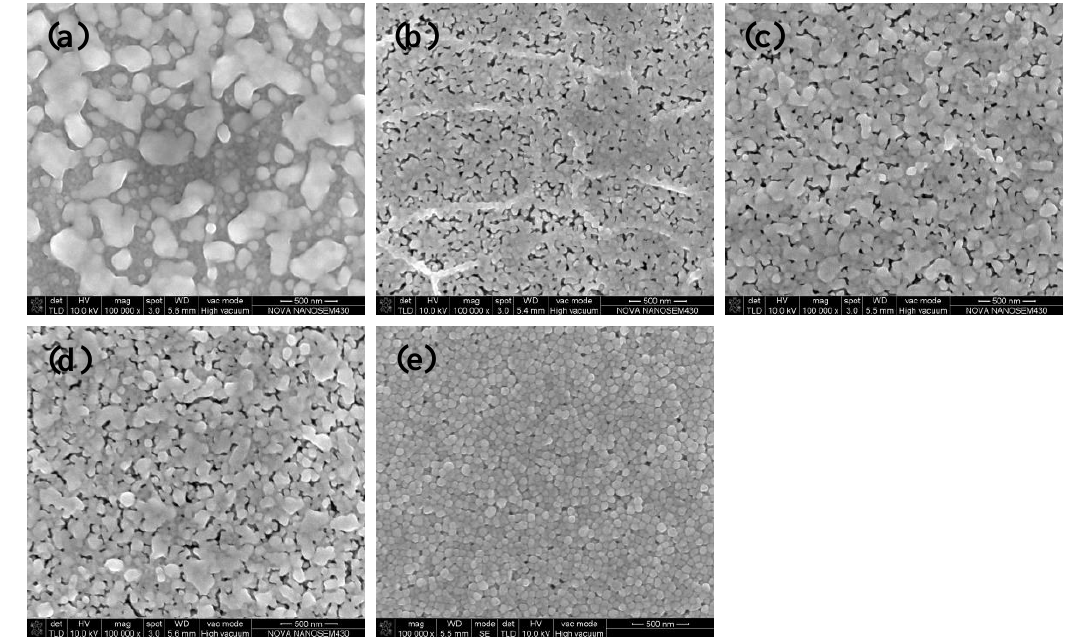
Figure 4. SEM images of silver films with UV curing at: ( a ) D = 37 cm for 270 s; ( b ) D = 23 cm for 270 s; ( c ) D = 23 cm for 480 s; ( d ) D = 25 cm for 480 s; ( e ) D = 25 cm for 480 s [20]. ( a – d ) were the films based on MOD ink while ( e ) was the film based on NP ink. Table 1. Comparison of resistance of silver films between the previous work and this work.